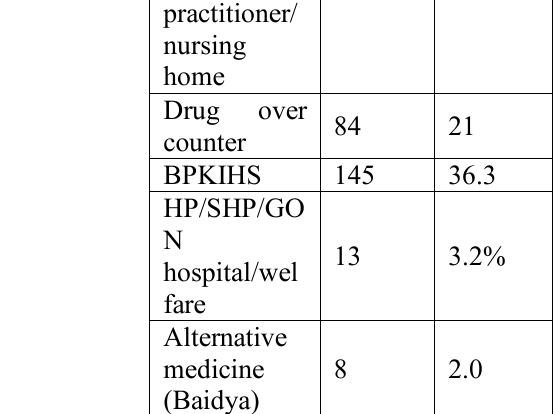
Table 3: The pattern of health seeking habits